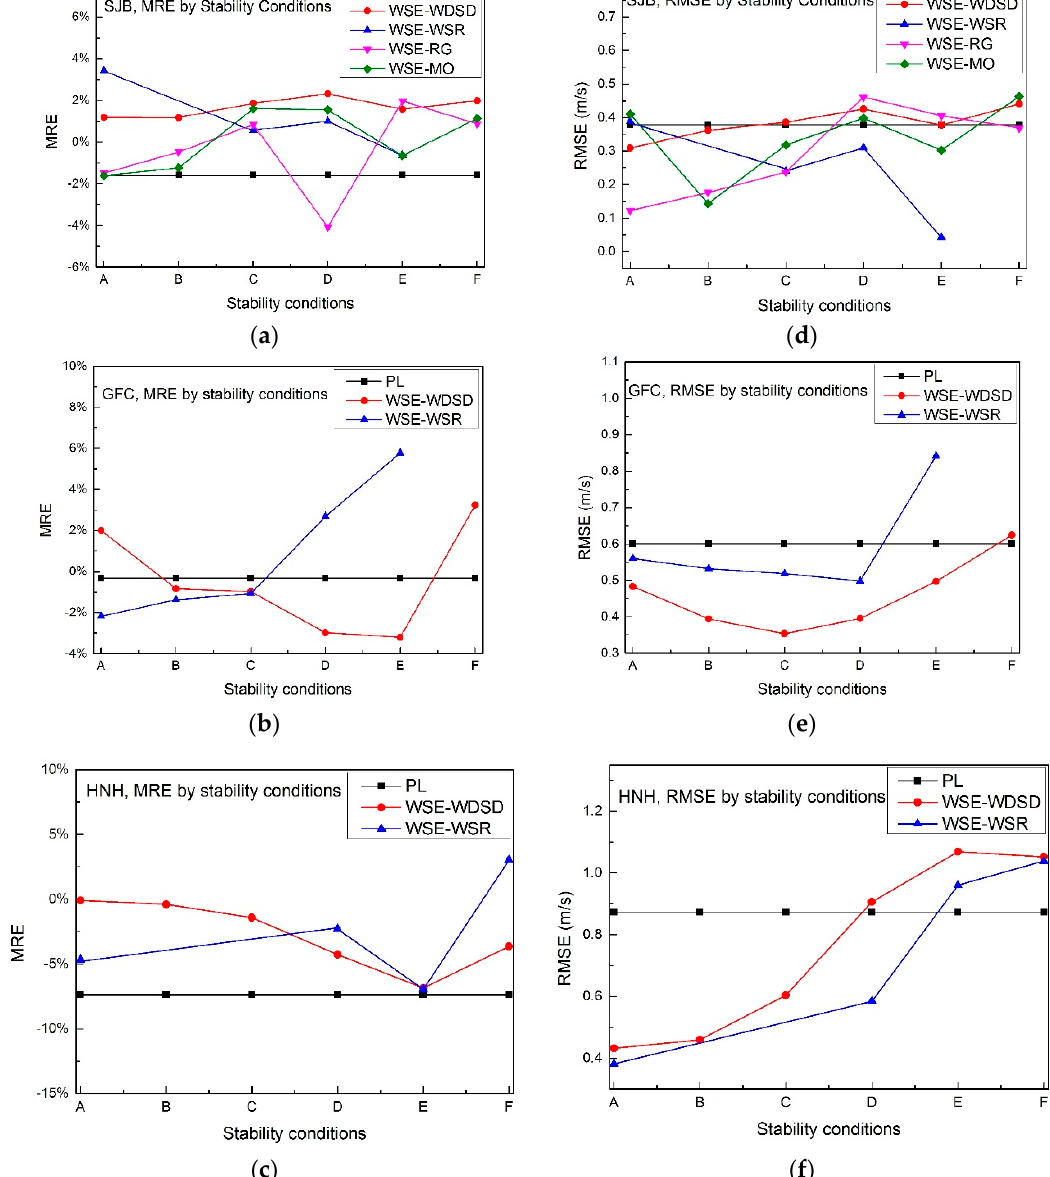
Figure 5. ( a – c ) MREs and ( d – f ) RMSEs between the measured and calculated values under different atmospheric stabilities conditions in the three different areas.